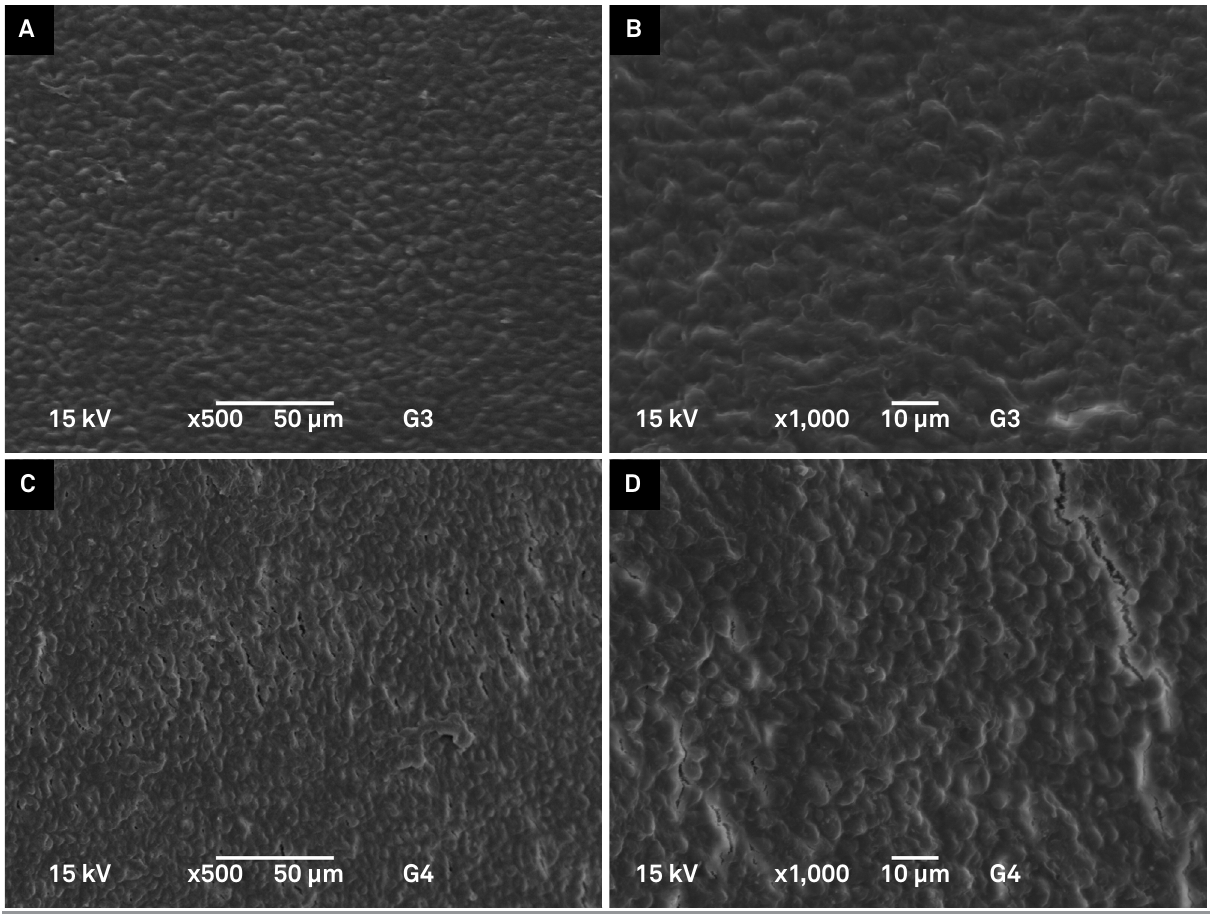
Figure 2. SEM representative image of samples from groups 3 (A and B) and 4 (C and D). In group 3, the dentin tubules are not visible due to the deposition of minerals from the dentifrice. In C and D, even though the laser has been used, the surfaces have the same characteristics as the samples from group 3. Magnification of 500× (A and C) and 1000× and (B and